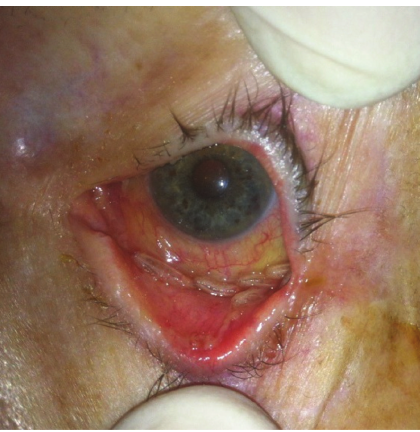
Figure1:Retractionofthelefteyelidrevealedmultiplelarvaeresting in the inferior fornix. Mucopurulent discharge can also be